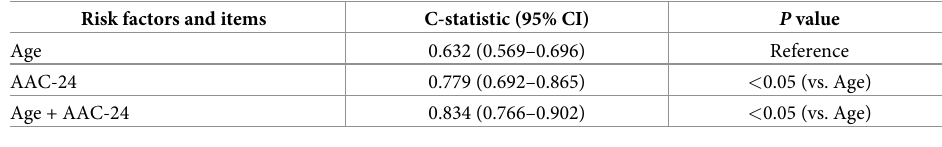
Table 7. C-statistic and measures and model fit for the conventional risk factors of age and AAC-24. Risk factors and